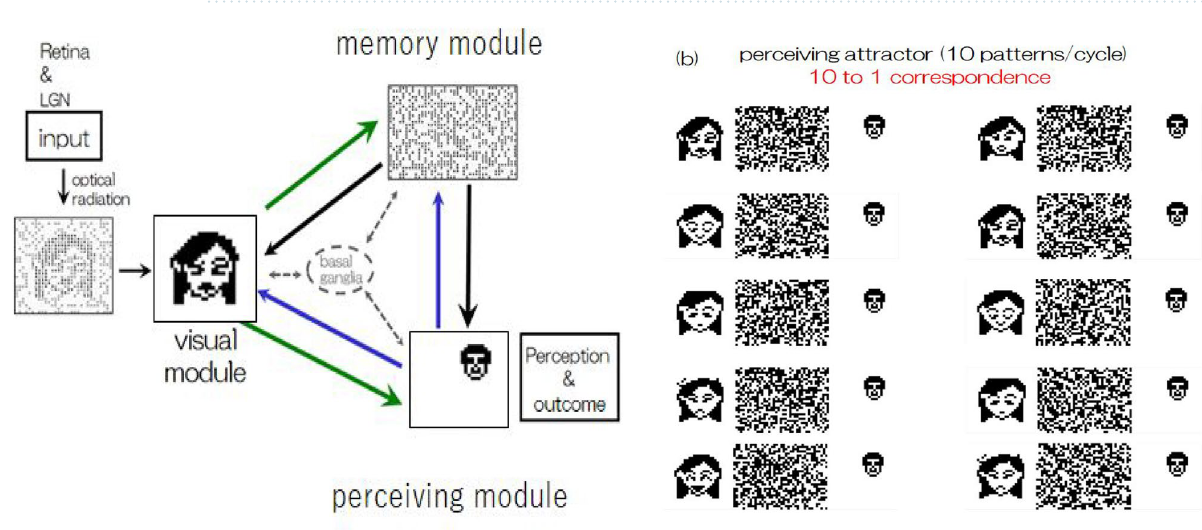
Figure 4. ( a ) Block diagram of a perceiving attractor in our three module model, where neuron activity is represented by bit patterns for convenience sake to visualize them. ( b ) One of the employed perceiving attractors, each of which consists of 10 periodic sequence of bit patterns (state vectors) in each